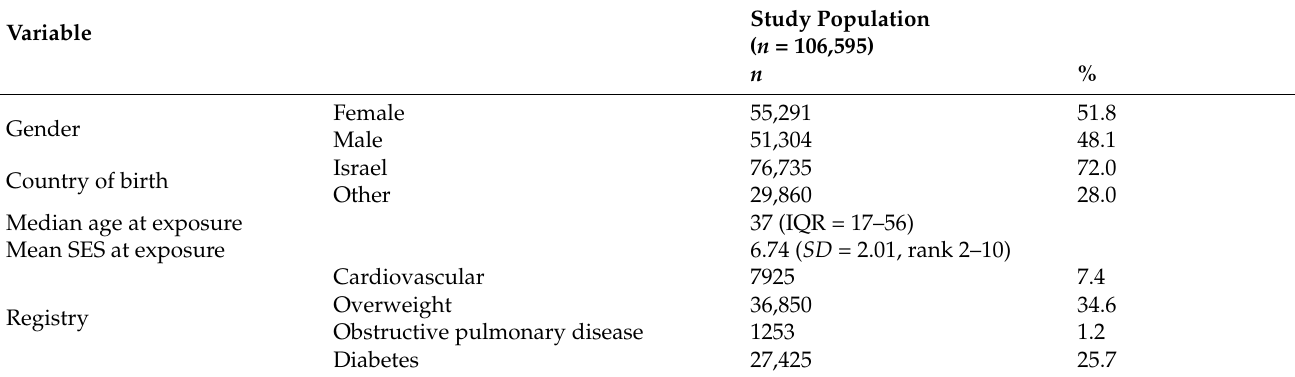
Table 1. Socio-demographic characteristics of the study population.